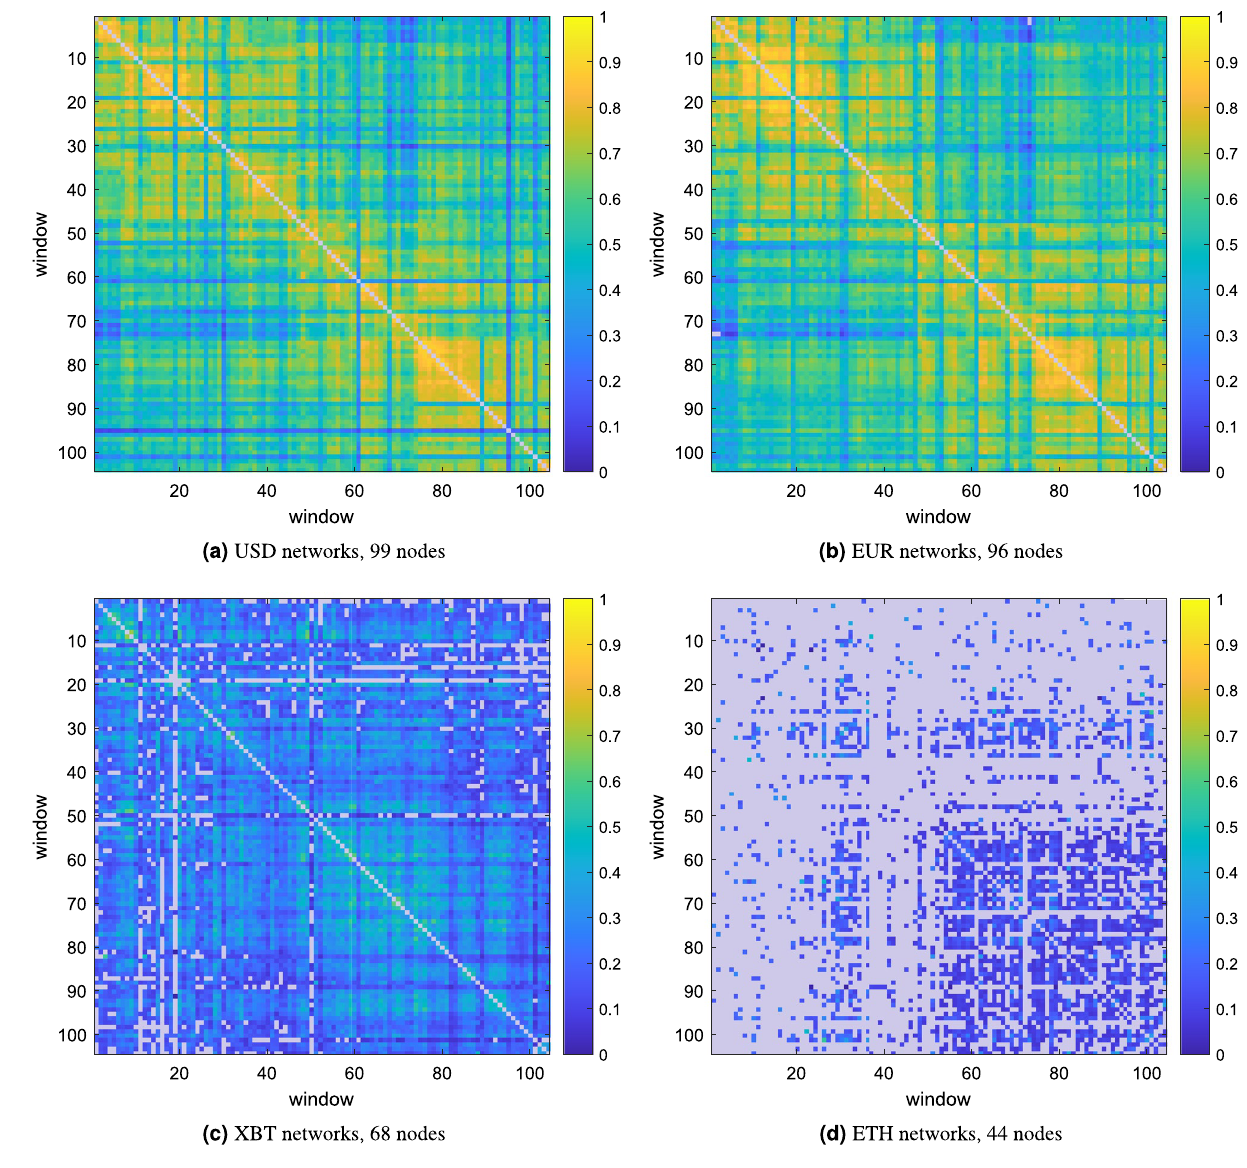
Figure 9. The Pearson correlation between adjacency matrices at different time windows. The element